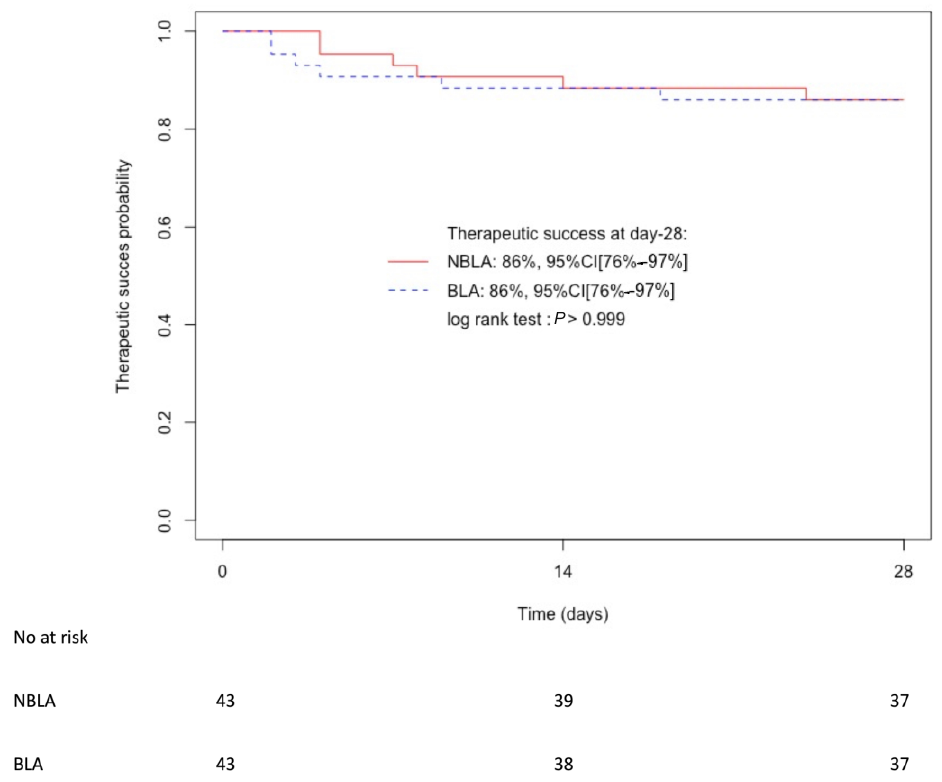
Figure 2. Kaplan – Meier curves of therapeutic success probability in non-beta-lactam allergic Figure 2. Kaplan–Meier curves of therapeutic success probability in non-beta-lactam allergic (NBLA) (NBLA) patients and beta-lactam allergic (BLA) patients. CI: confidence interval. patients and beta-lactam allergic (BLA) patients. CI: confidence interval. Table 4. Univariate and multivariate analysis of factors associated with therapeutic